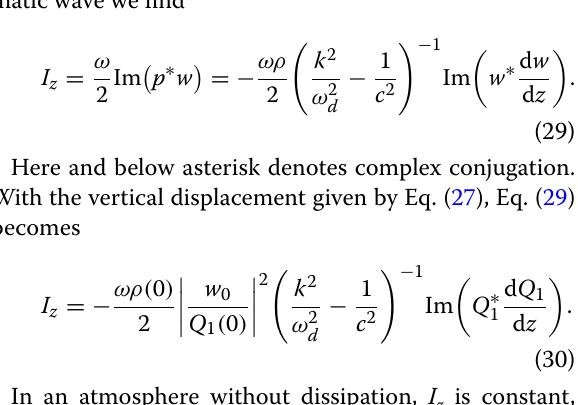
The vertical component of the power flux density in AGWs is (Godin 1997)